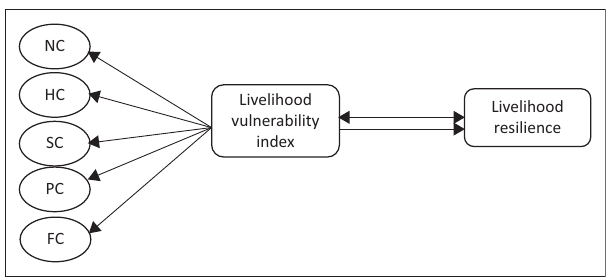
FIGURE 4: Conceptual